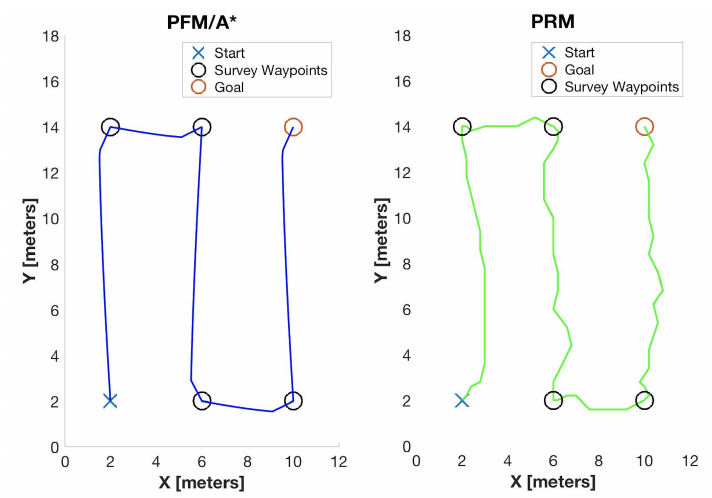
Figure 22. Case Study III 5-MF 3D plot relating the input variables (path percent error and average vehicle speed) with the corresponding performance scores.